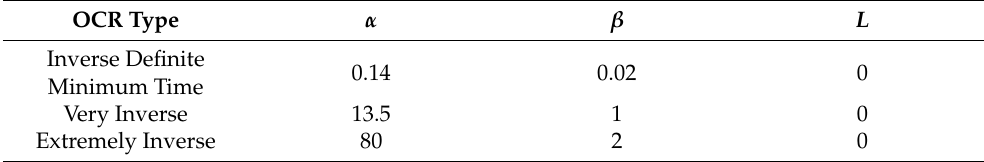
Table 1. Overcurrent relay